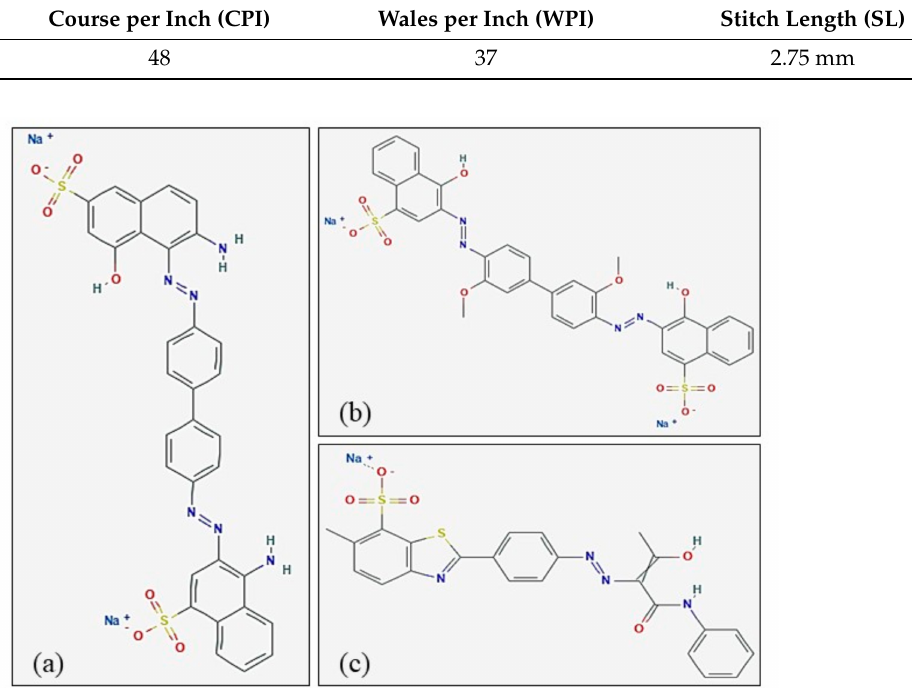
Table 2. Geometric parameters of the fabric.